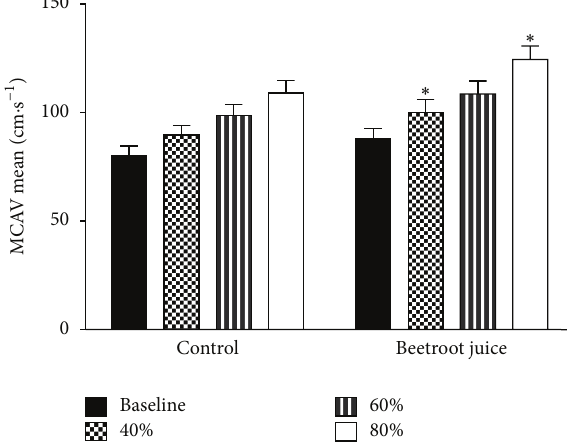
Figure 1: Effects of beetroot juice treatment on middle cerebral arterial blood flow velocity. Bars represent means ± standard errors for middle cerebral artery mean blood flow velocity, expressed in cm ⋅ s −1 . The study subjects were 12 healthy, normotensive young adult African-American females. Left panel: placebo control orange juice treatment. Right panel: beetroot juice treatment. ∗ Difference between control and beetroot juice treatments statistically signifi- cant at 𝑃 < 0.05